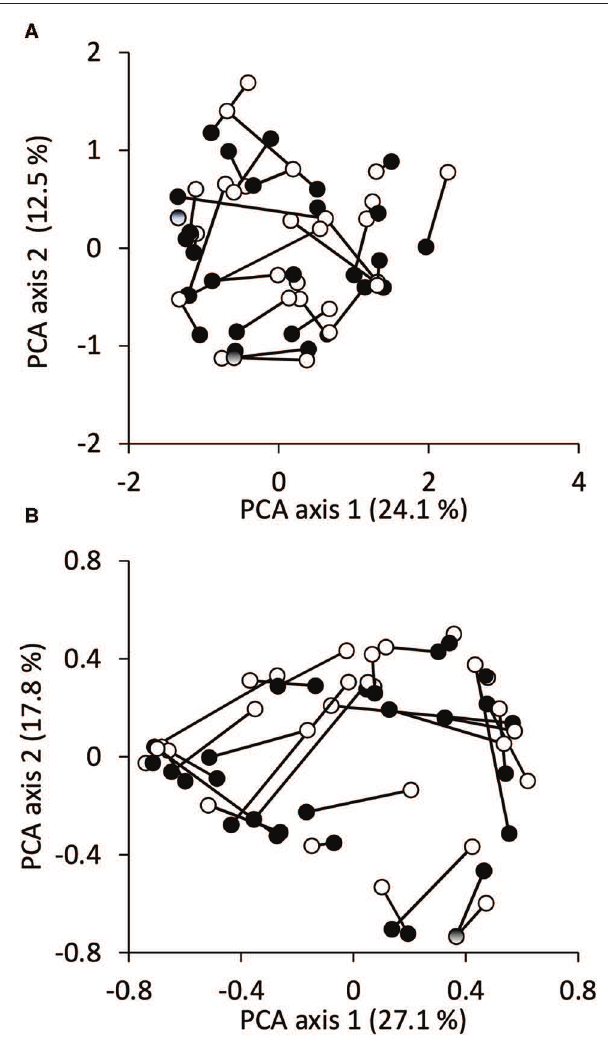
FIGURE 3 | Ordination plot of the PCA of the studied urban and their associated reference sites (linked to each other) based on (A) fish species composition and (B) abundance data. Black symbols: urban sites; white symbols: reference